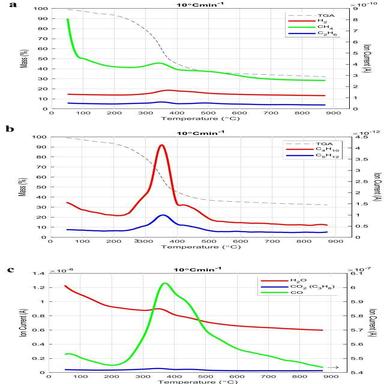
TGA – MS pyrolysis profiles of Poplar fluff sample: a – H2, CH4 and C2H6 evolution profiles, b – C4H10 and C5H12 evolution profiles, and c – H2O, CO2 (C3H8) and CO evolution profiles.